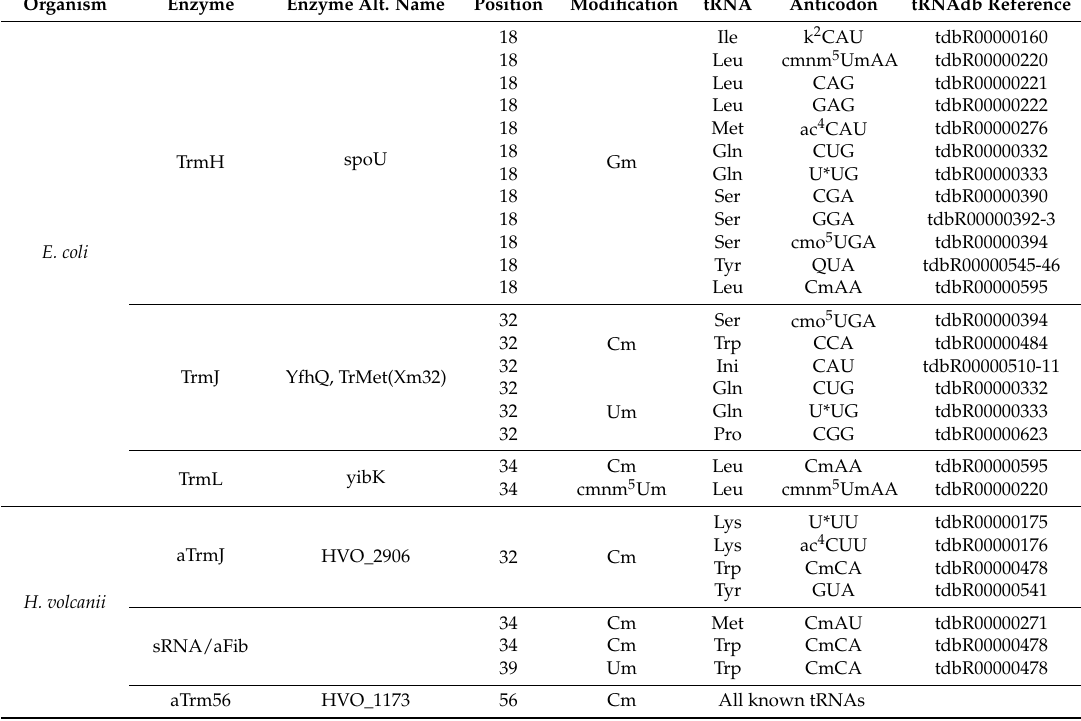
Table 1. Known transfer RNA (tRNA):2 (cid:48) - O -methyltransferases in model organisms ( Escherichia coli , Haloferax volcanii , Saccharomyces cerevisiae , Homo sapiens ) and their tRNA substrates.